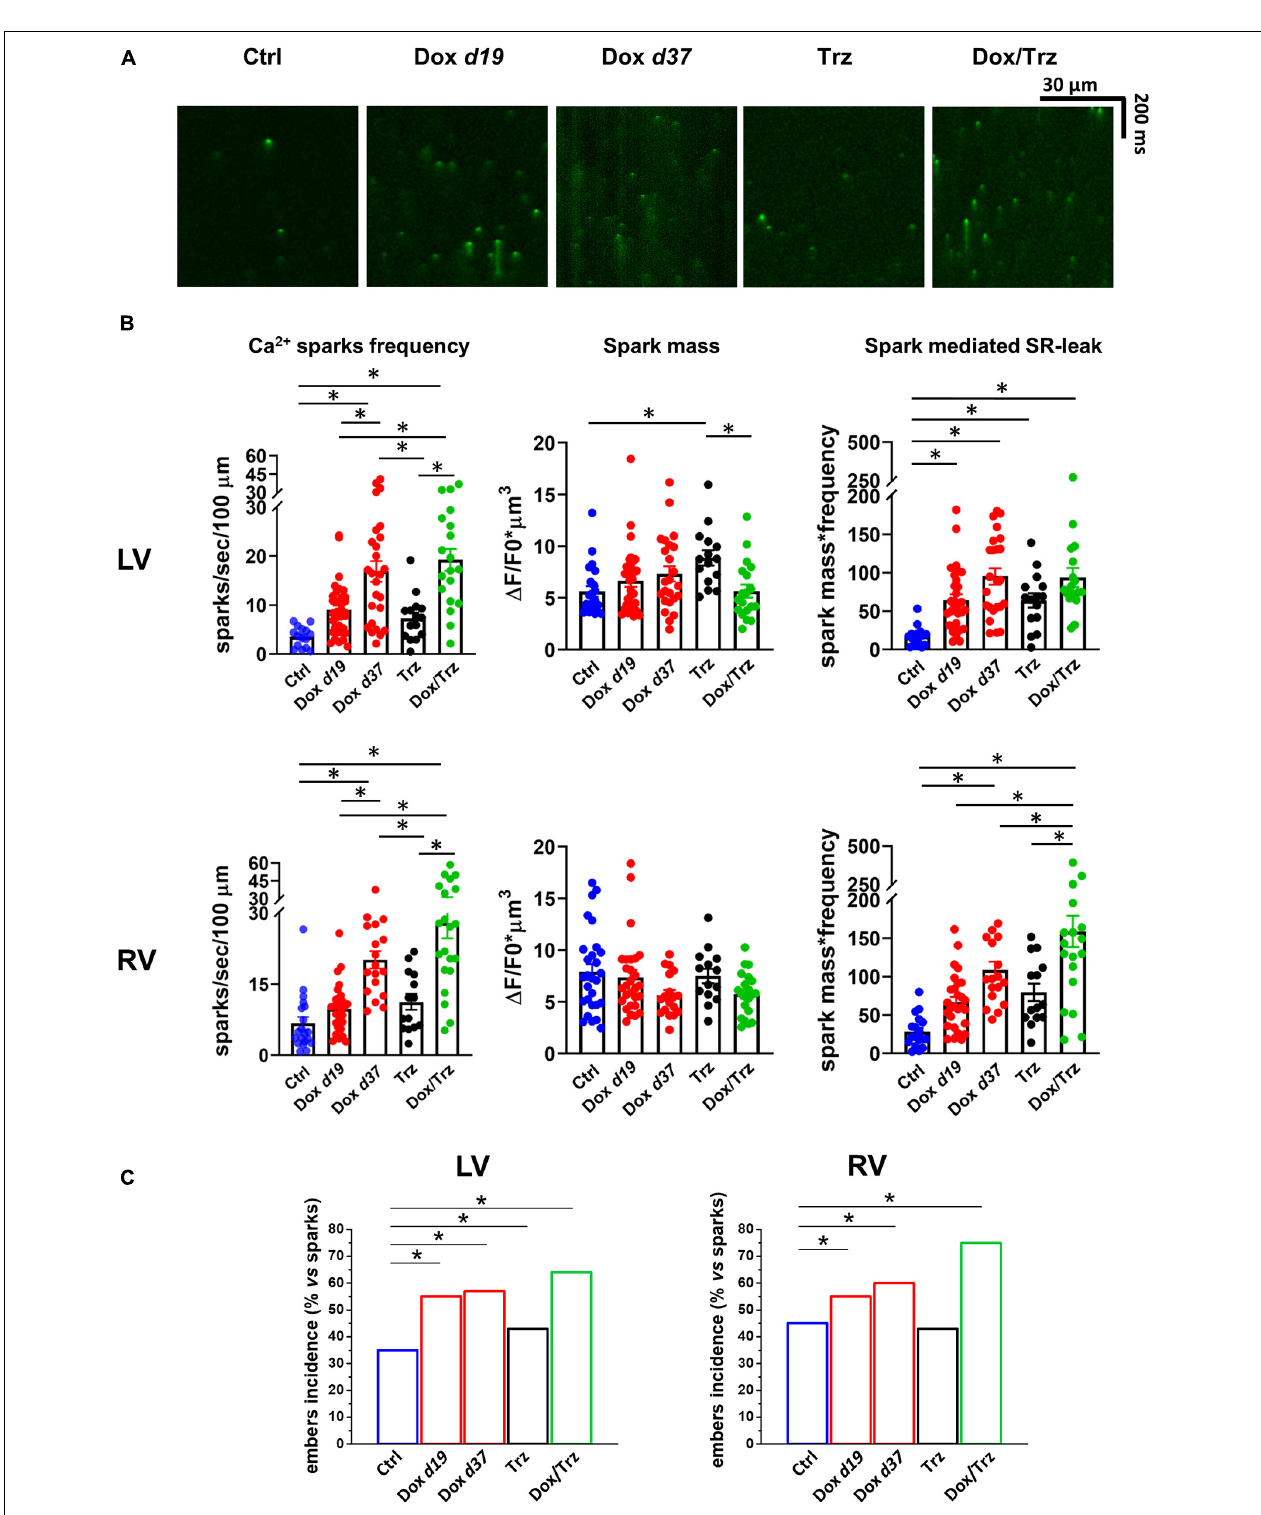
FIGURE 6 | Effects of Dox and Trz on Ca 2 + sparks. (A) Confocal xt-images of FLuo4-AM loaded LV CMs in all groups. (B) Quantitative analyses of Ca 2 + sparks frequency, spark mass, and sparks-mediated SR Ca 2 + leak ( n = 14–24 cells from 3 to 5 rats per group). (C) Quantitative analysis of Ca 2 + “embers” (i.e., Ca 2 + sparks with FDHM > 20 ms). One-way ANOVA was used to test for significant differences between multiple groups in panel (B) , and Chi 2 -test was used for comparison of categorical variables in panel (C) . Bars are mean ± SEM (* p < 0.05).